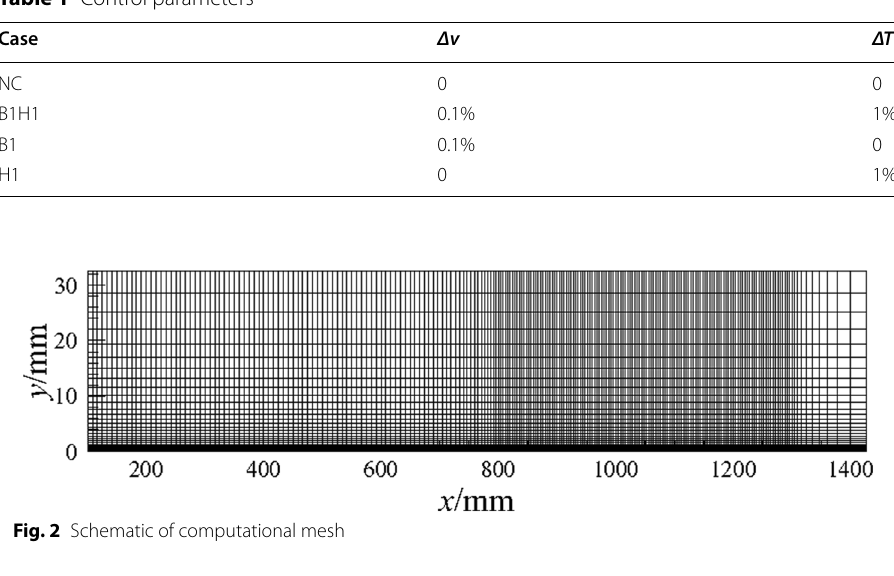
Table 2 Computational parameters and mesh scales in NC case at x